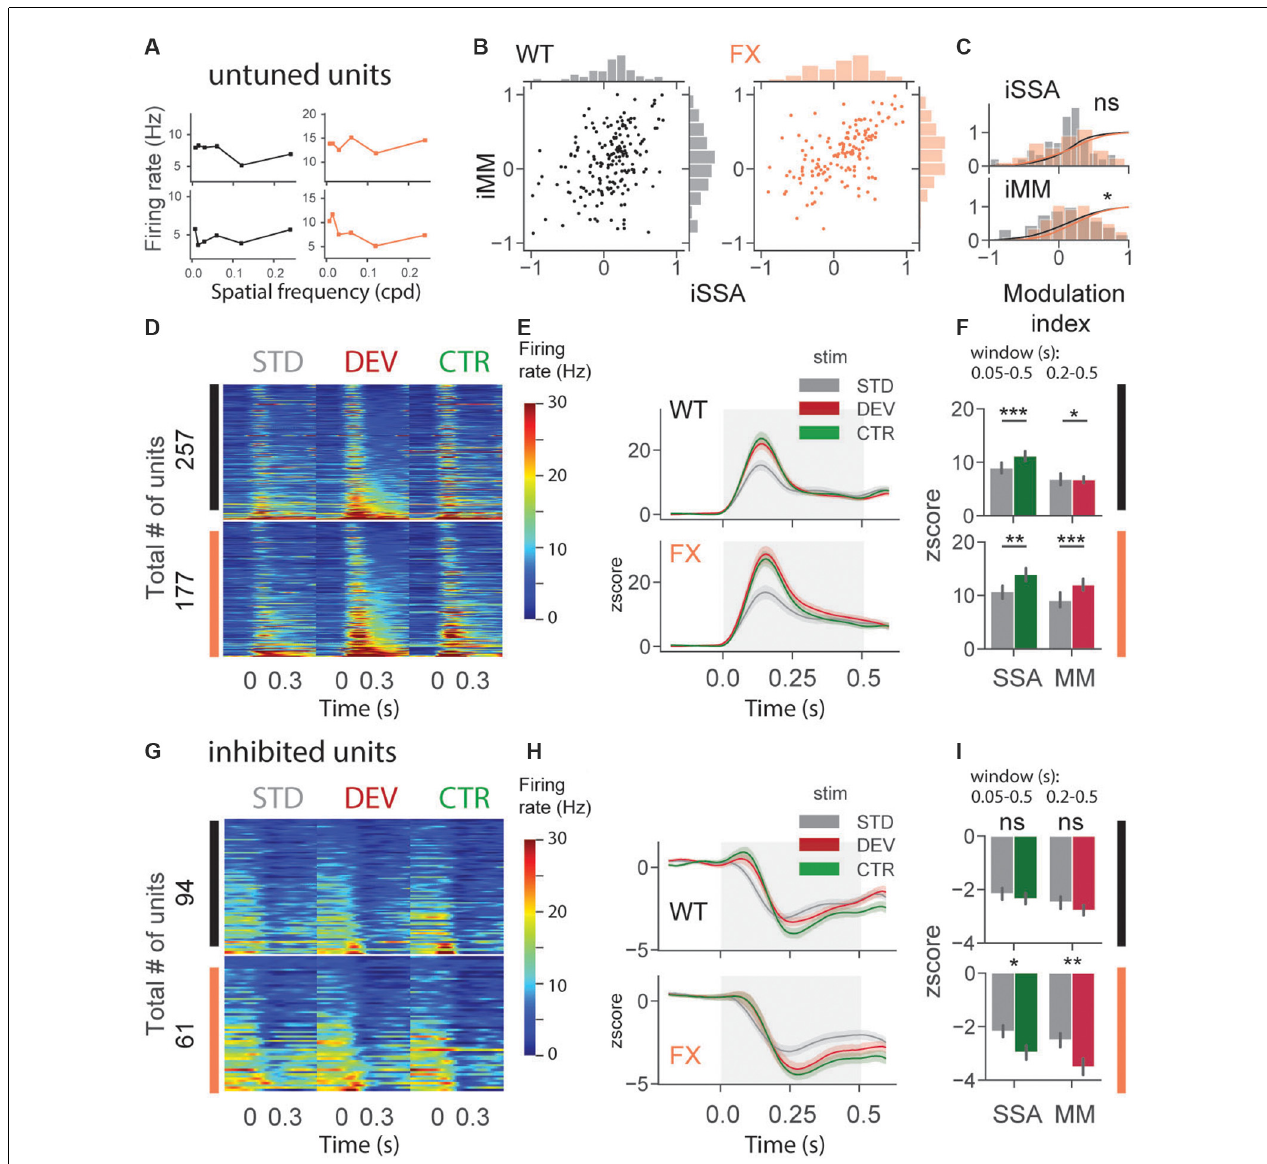
FIGURE 5 | Altered oddball responses in untuned and inhibited units of FX mice. (A) Example SF tuning curves of untuned neurons. Two criteria were used to identify those units: (1) failure of DOG model fitting or (2) high fitting error (>0.9). (B) Distribution of iSSA and iMM modulation indices for WT and FX mice (each point is a single unit). (C) Superimposed distributions of iSSA and iMM with KDE. (D) The heatmaps show single-unit firing rates in response to STD, DEV, and CTR stimuli across different genotypes. (E) The line plots represent mean z -scored responses of the units from the heatmaps. (F) The point plots show the mean ± SEM of the z -scored firing rate between 0.05–0.5 s for SSA and 0.2–0.5 s for MM relative to the stimulus onset. (G–I) Same as in (D–F) but for inhibited units. * p < 0.05, ** p < 0.01, *** p < 0.001, ns = not